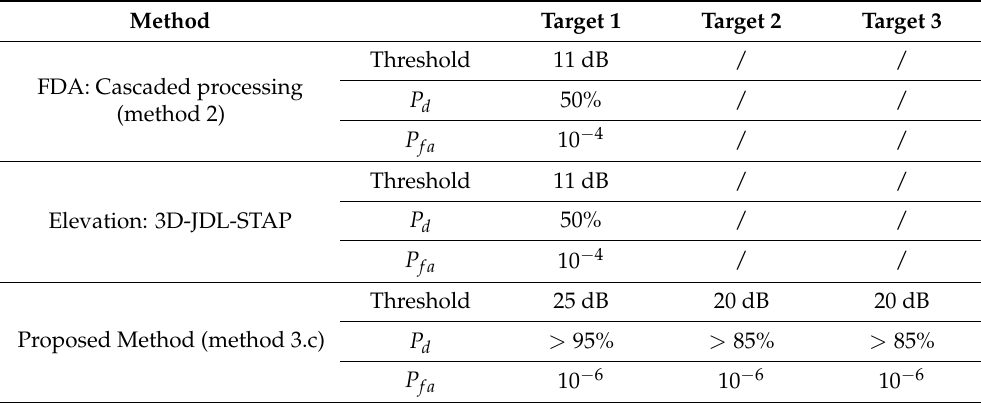
Table 3. The performance of faint moving target detection by different